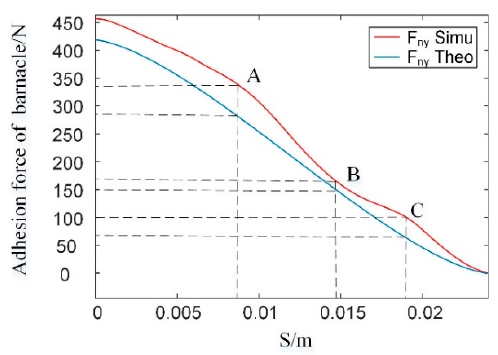
Figure 16. Simulation and analytical results of barnacle adhesion force.